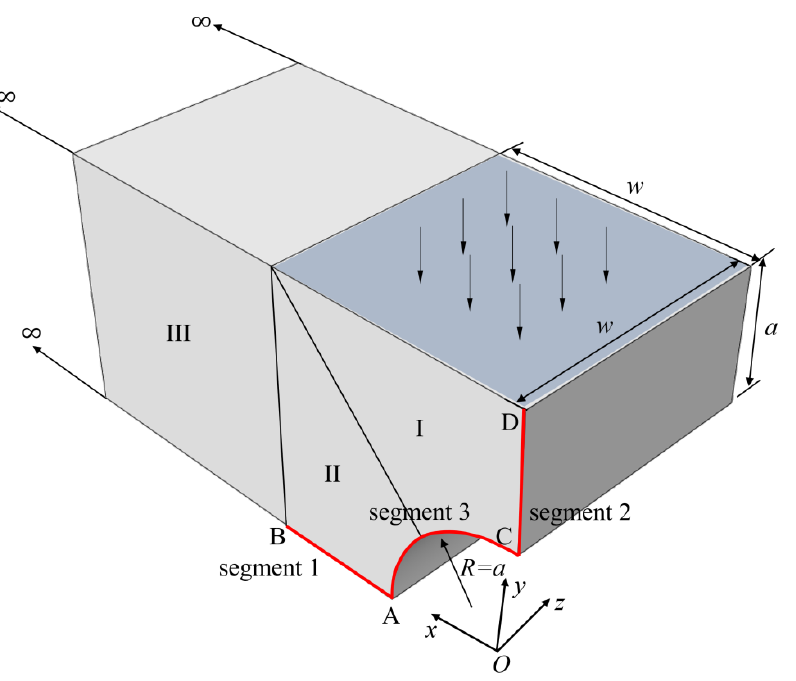
Figure 7. Half model of simplified arch bridge model for FBM.